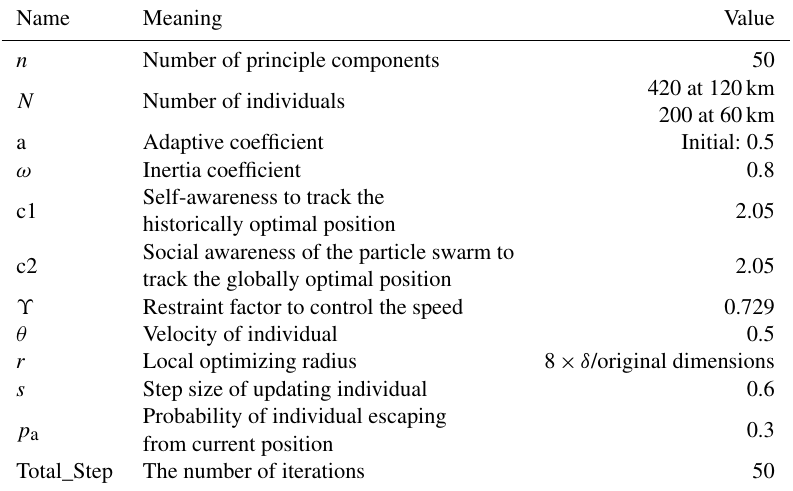
Table 1. The parameters of the